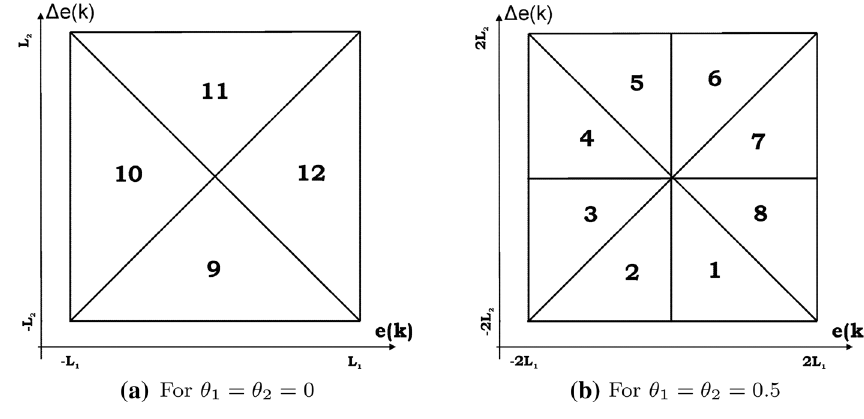
Table 2 Expressions of gains with 0 < 𝜃 1 ∕ 𝜃 2 < 0.5 ( X 1 = a 1 and X a 2 = 2 for 𝛾 1 , and